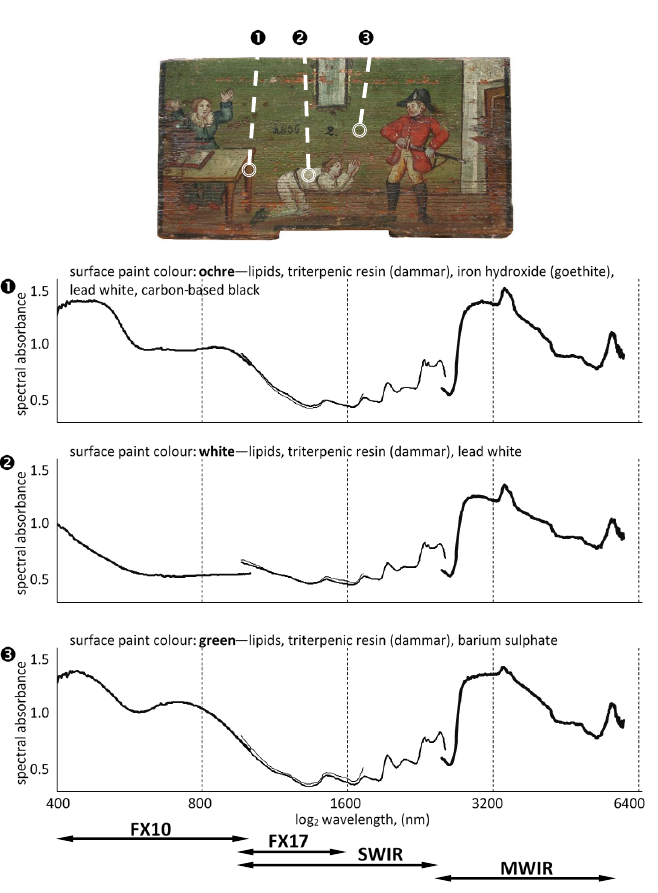
Figure 6. The specific regions of interest (ROIs) and the corresponding (average) spectra collected using the investigated hyperspectral cameras.